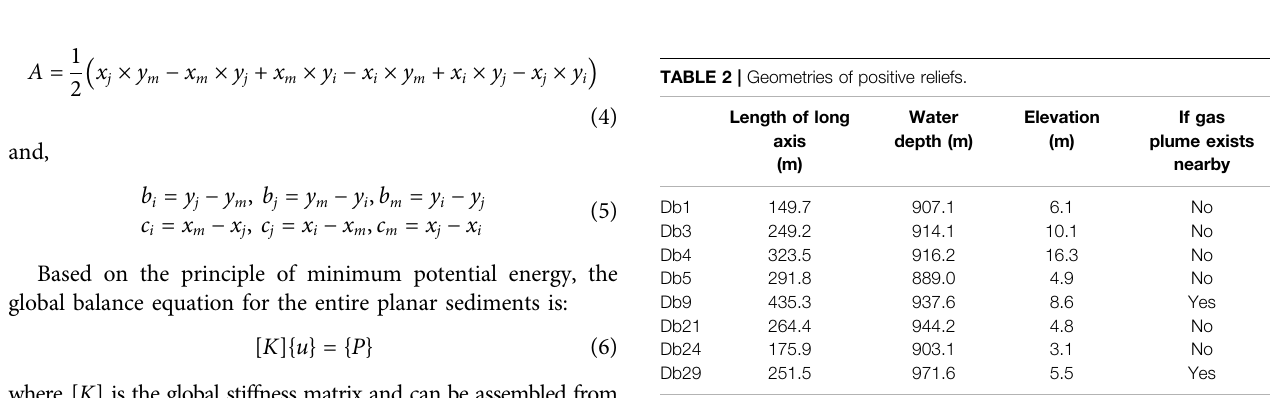
FIGURE 7 | Zoomed-in fi gure showing the bathymetry (A) and the spatial relationship between the fault, the restraining bend and two emission sites (B) . The contour interval is 2.5 m. (C) Three bathymetric pro fi les transecting the fault scarp and the positive reliefs of Db21 and 29.